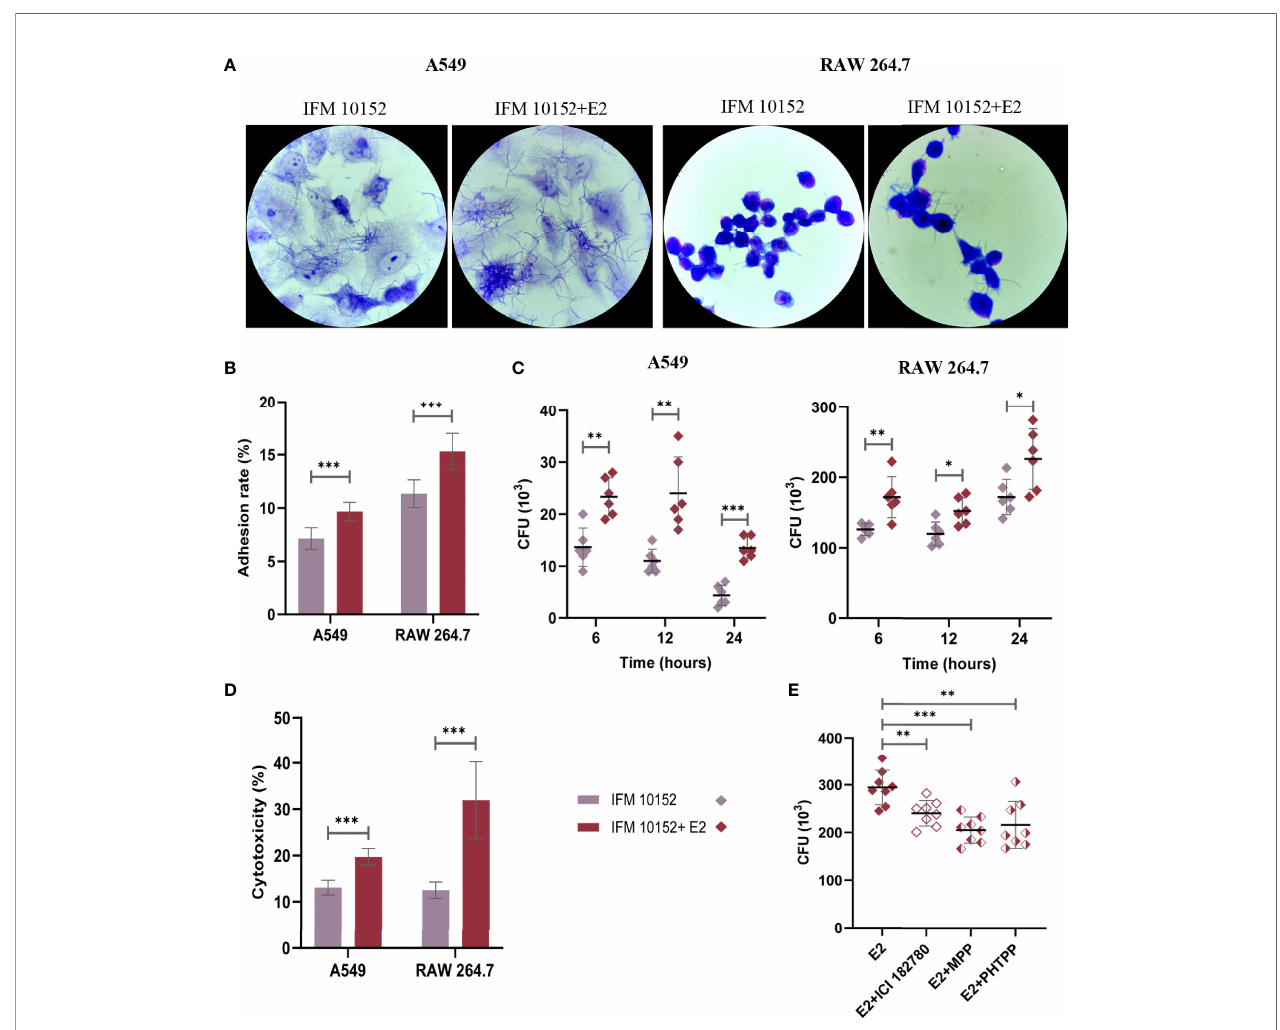
FIGURE 4 | E2 facilitates adhesion and invasion of N. farcinica IFM 10152 into host cells through ER a and ER b signaling. (A – E) A549 and RAW 264.7 cells were treated with or without 50 nM E2 for 16 – 18 h prior to Nocardia infection. Electron microscopic observation (A) and adhesion rate (B) of bacterial strains to A549 (left) and RAW 264.7 (right) cells after 1 h of infection. (C) Invasion of bacterial strains into A549 (left) and RAW 264.7 (right) cells after 6, 12, and 24 h of infection. (D) The cytotoxicity of N. farcinica IFM 10152 to A549 and RAW 264.7 cells after 8 h of infection. (E) Bacterial survival in RAW 264.7 cells treated with ICI 182780, MPP or PHTPP. Lines display means with SEM. Data are from 3 independent experiments. * P < 0.05, ** P < 0.01, and *** P <